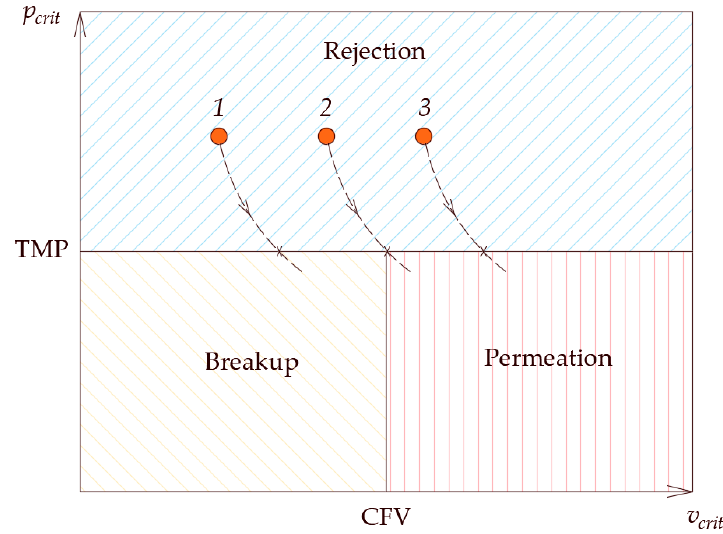
Figure 15. When the droplet is initially in state 1, the critical pressure is larger than the TMP (i.e., no permeation would occur) and the critical velocity of dislodgment is smaller than the CFV (i.e., rejection would occur). As the contact angle decreases, the critical entry pressure decreases and the critical velocity of dislodgment increases, as depicted by the dashed line. If the incremental decrease in the contact angle is small, the droplet will cross the constant TMP line, at which point, permeation starts, and if the critical velocity remains smaller than the CFV, breakup will occur. A similar pattern can be noticed for scenarios 2 and 3. In scenario 3, the droplet can either be pinned in the neighborhood of the TMP line or permeate.